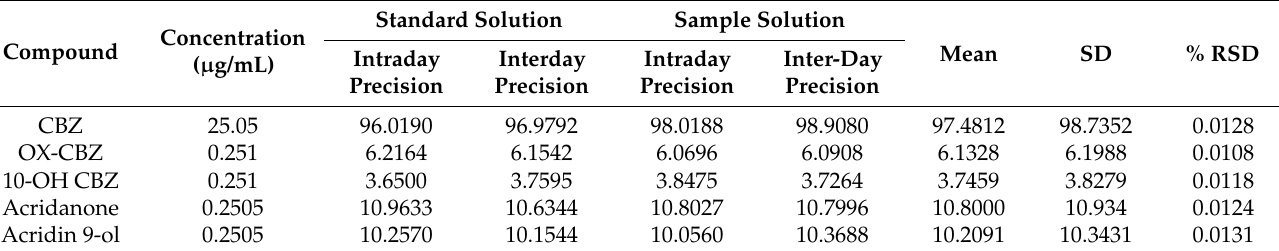
Table 7. Precision values of CBZ and the detected degradation intermediates in